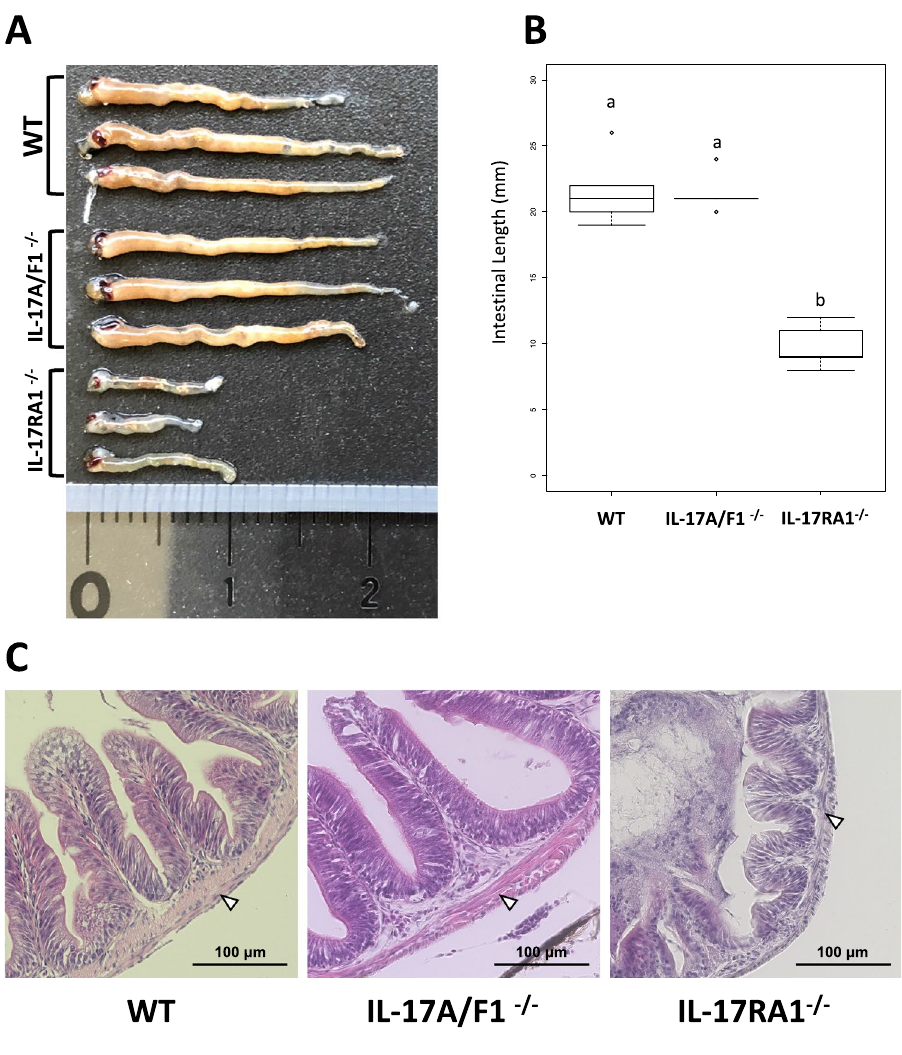
Figure 3. Comparisons of apparent differences in the intestinal tracts of WT, IL-17A/F1-KO, and IL-17RA1-KO medaka. ( A,B ) Comparison of the intestinal tract length. The intestinal tract of IL-17RA1-KO medaka was significantly shorter than that of WT and IL-17A/F1-KO medaka. ( C ) Hematoxylin and eosin staining of the anterior intestine. Histological changes in intestinal villus tissue were not observed in the intestinal tract of IL-17A/F1-KO medaka. However, thinner muscle layers under the intestinal villus were observed in IL-17RA1-KO medaka. The observed villus tissues of the intestinal tract were sampled from the anterior intestinal section of a 4-month-old adult fish. Different letters abovethe bars indicate significant difference at P < 0.05 as indicated by Tukey–Kramer multiple comparison tests in R (version 3.5.3) after one-way ANOVA. The data shown were obtained in one experiment with five individual fish (n =